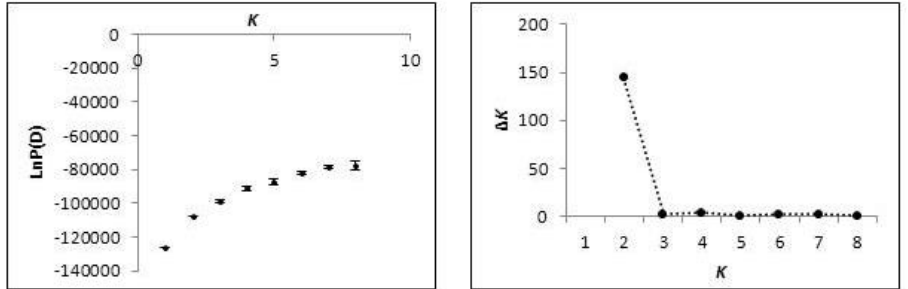
Figure 3. Summary evaluation of the posterior probability values [LnP(D)] used for the determination of the most likely number of clusters ( K ) from STRUCTURE simulations.